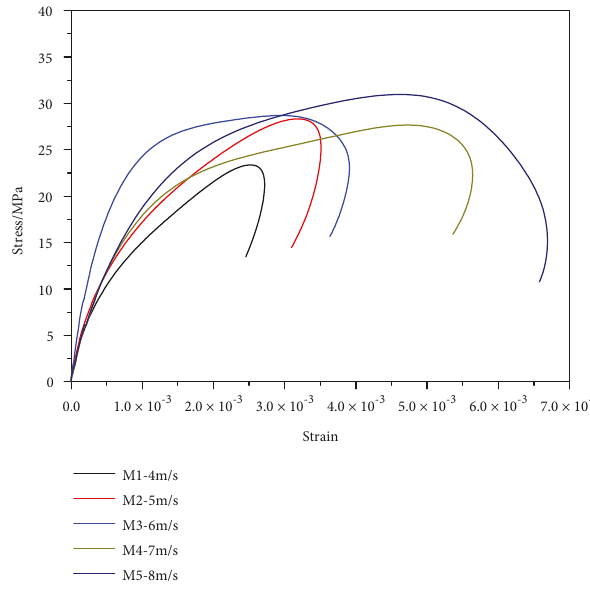
Figure 7: Stress-strain curves of specimens at di ff erent impact